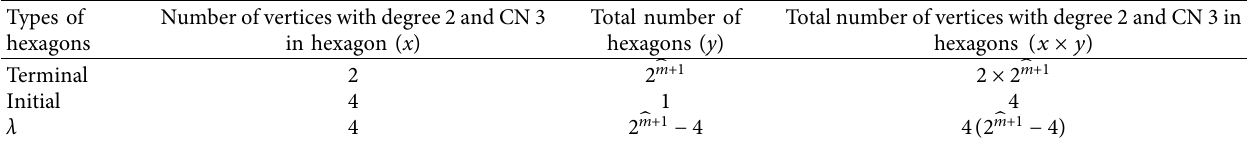
Table 4: Total number of vertices with degree 2 and CN 3 in ζ